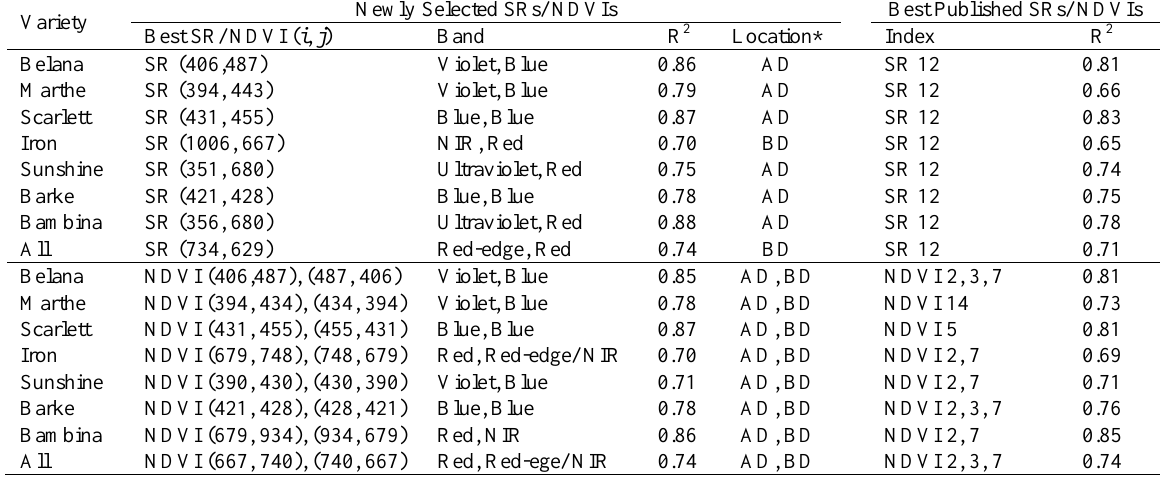
Table 2. Best newly selected SRs/ NDVIs and best published SRs/ NDVIs for estimating LCC in different varieties. Newly Selected SRs/ Variety